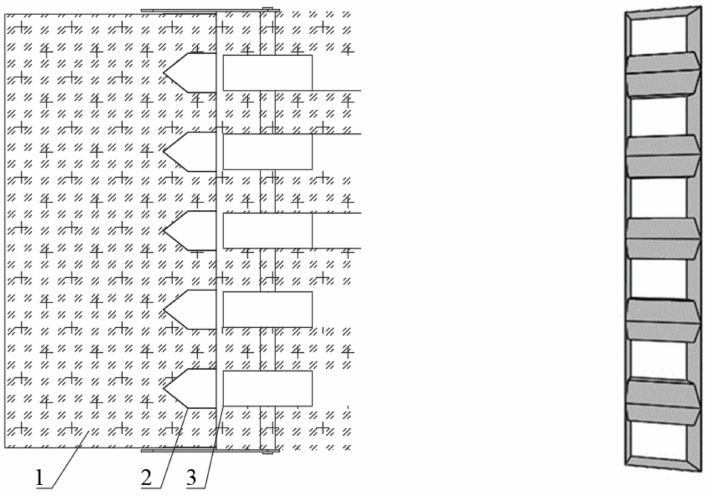
Figure 2. Workflow of broken straw division and strip laying. 1—full amount of straw; 2—diverting and strip-laying device; 3—seed belt in clean